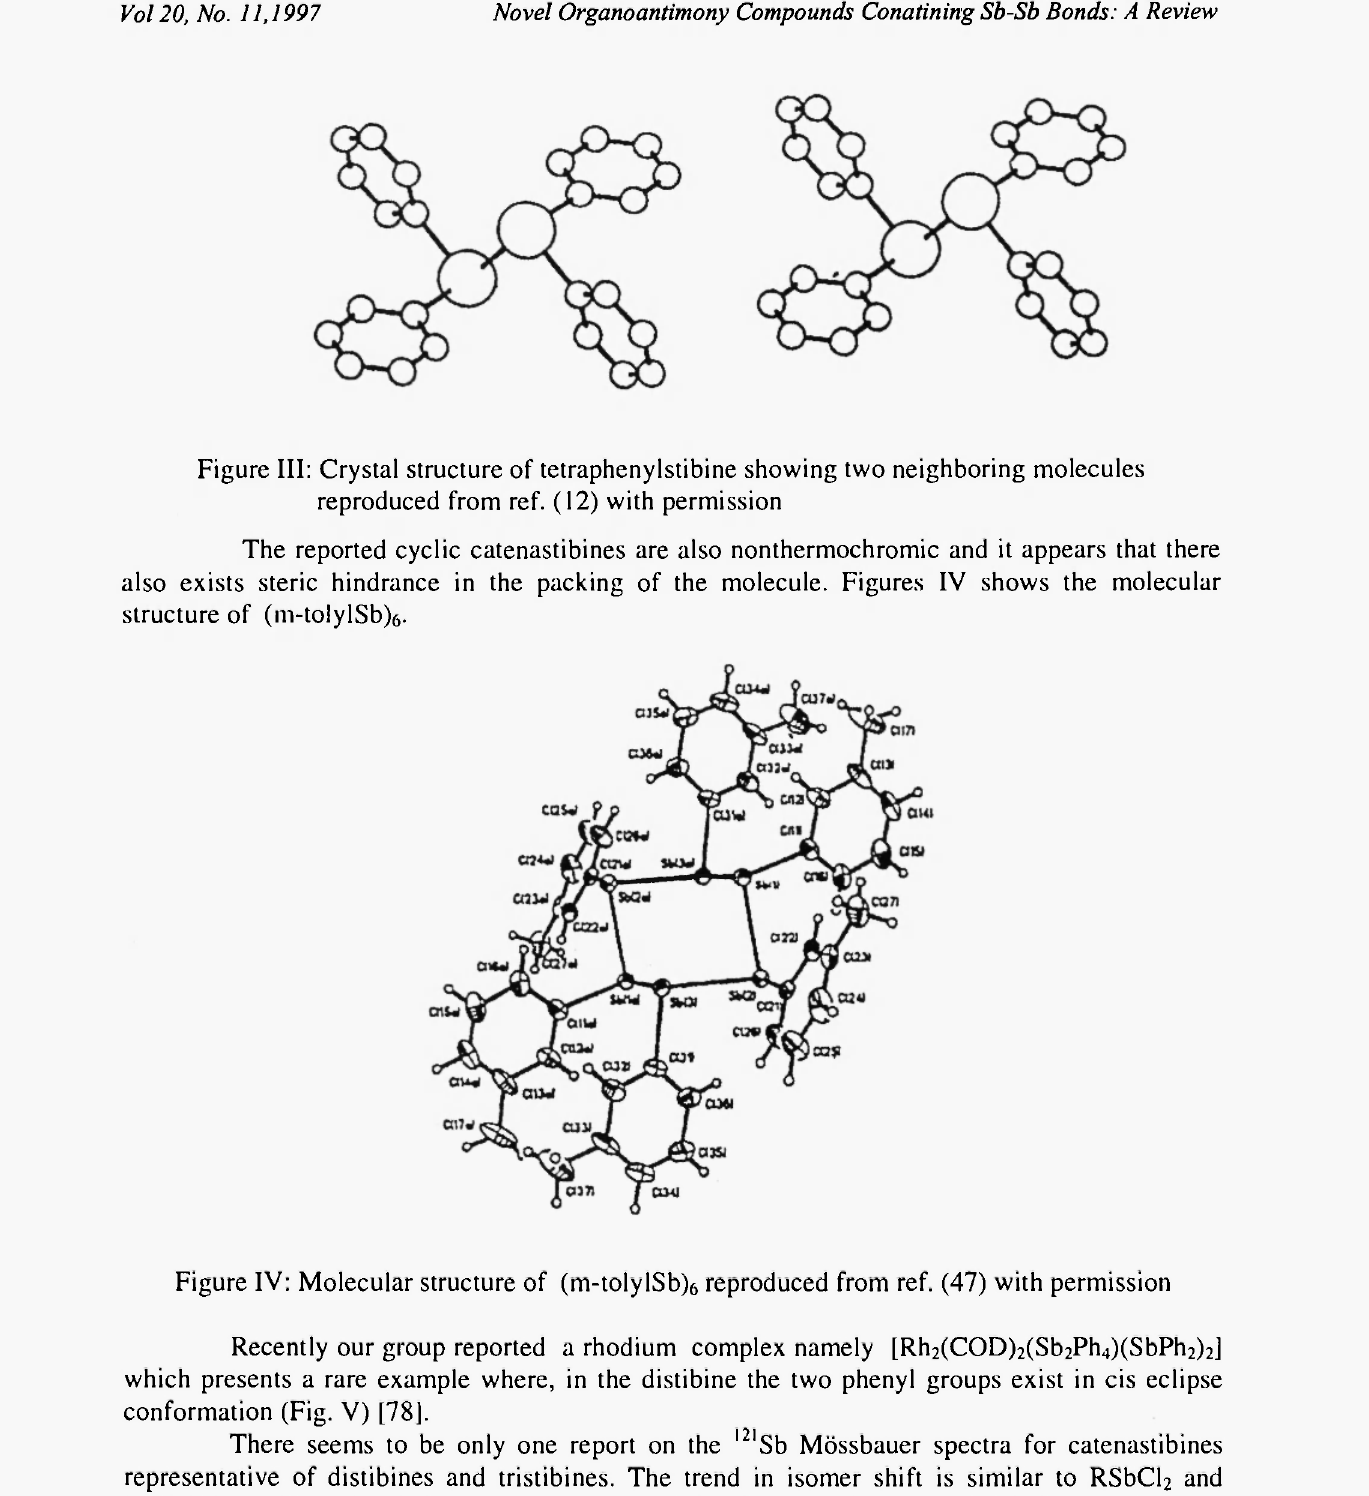
[Rh2(COD) 2 (Sb2Ph 4 )(SbPh 2